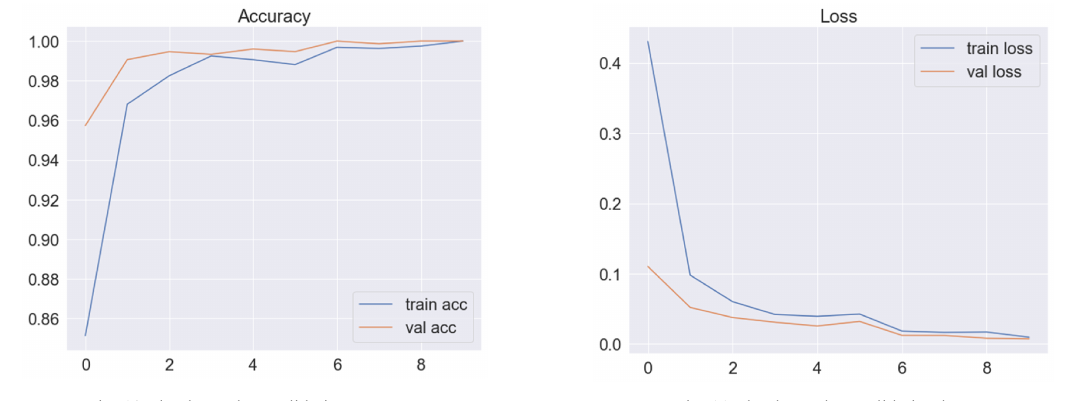
Fig. 10 The three-class validation accuracy Fig. 11 The three-class validation loss